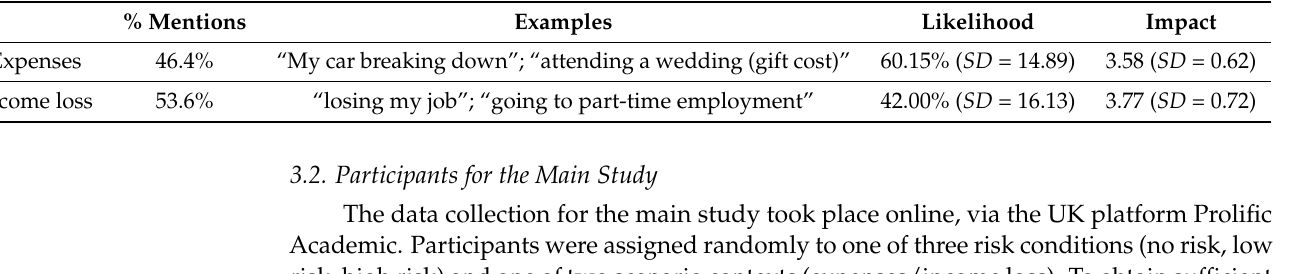
Table 1. Results of the pilot